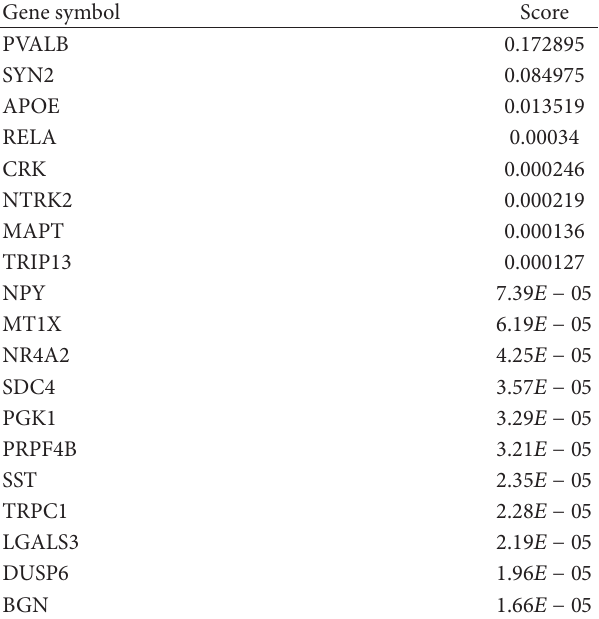
T 11: Prioritization of the genes presented in table 11, by Bio- Graph exploiting unsupervised methodologies for the identi�cation of causative SZ-associated genes. Genes with the higher nineteen scores are shown.